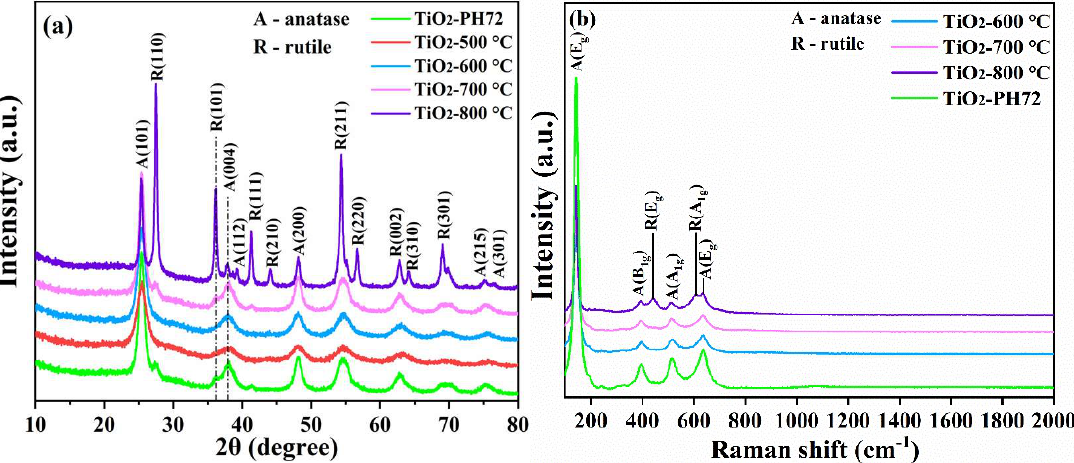
Figure 5. ( a ) XRD patterns and ( b ) Raman spectra of those TiO 2 fibers obtained after calcination at different temperatures and plasma treatments.